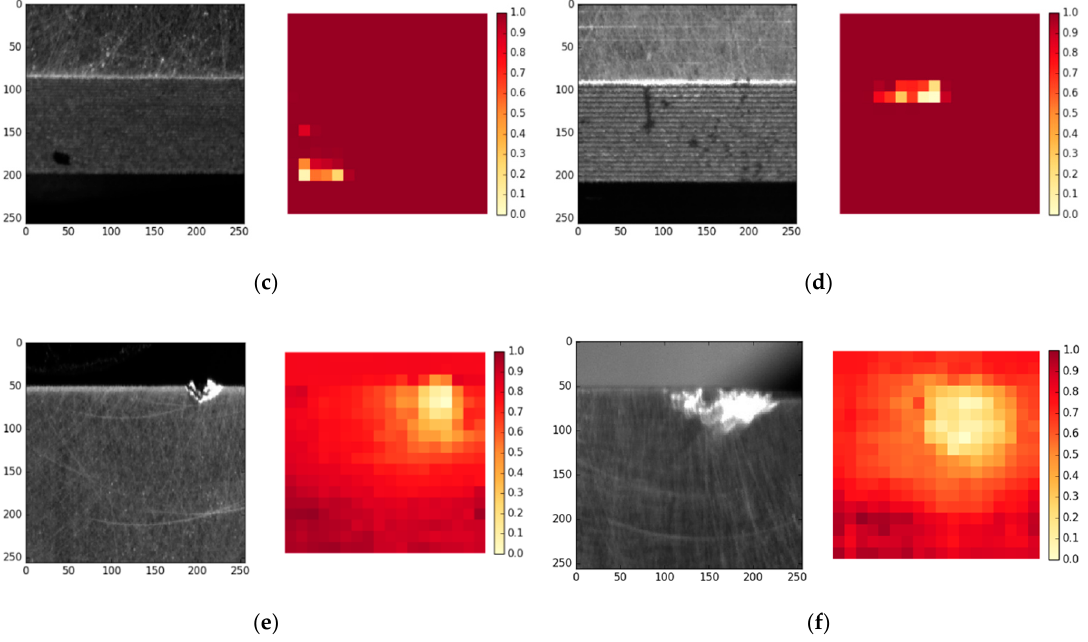
Figure 13. Occlusion experiments on a couple of roller surface defect images: ( a ) CC; ( b ) CSc; ( c ) CSt; ( d ) CSt; ( e ) EFC; ( f ) EFSF.